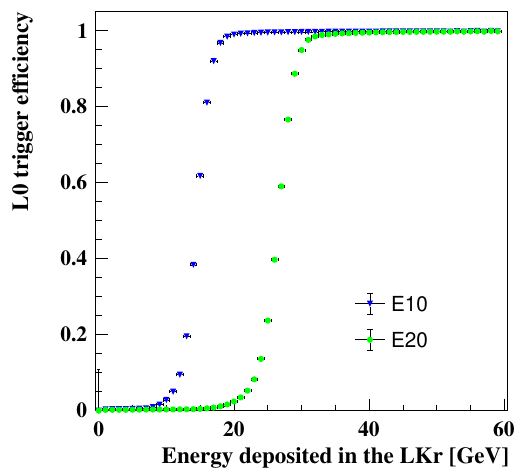
Figure 8. Efficiencies of the E10 and E20 trigger conditions as a function of LKr energy deposit, measured with a sample of K + → π + π + π − decays.